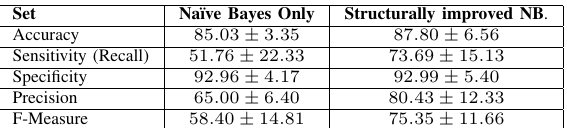
S AMPLES SORTED AFTER VOTER RANKING AND LABEL REASSIGNMENT .